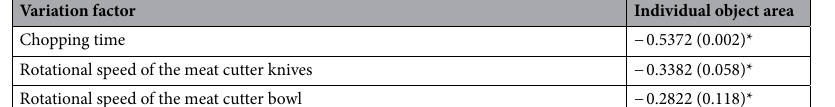
Variation factor Individual object area Chopping time − 0.5372 (0.002)* Rotational speed of the meat cutter knives